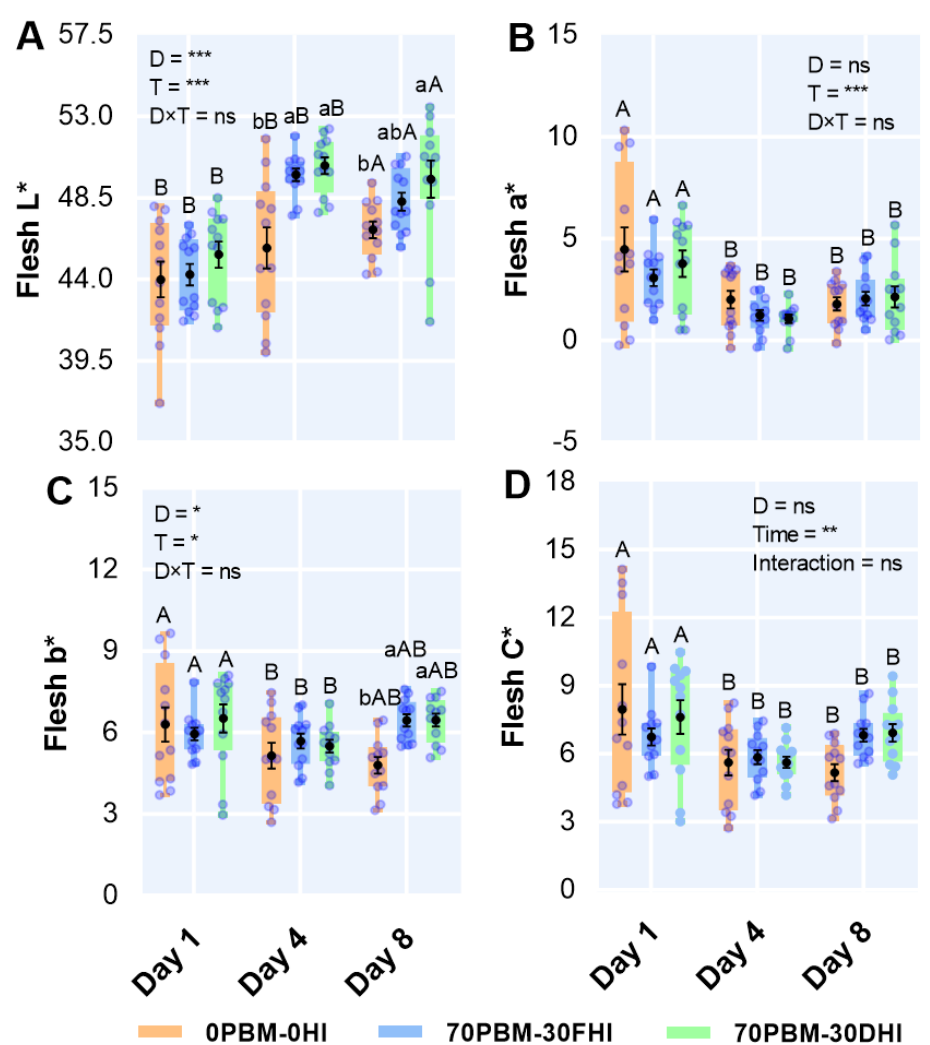
Figure 4. Changes in the fillet flesh color, including the lightness (L*) ( A ), redness (a*) ( B ), yellowness (b*) ( C ), and chroma (C*) ( D ) levels, after the 8-week feeding trial and at day 1, day 4 and day 8 when stored at 4 °C in barramundi fed complete replacement of fishmeal (FM) diets with mixtures of poultry by-product meal (PBM), full-fat Hermetia illucens (FHI), and partially defatted Hermetia illucens (DHI) larvae meal. Semi-transparent light blue round markers indicate individual datapoints ( n = 12), while the box–whisker plot of individual datapoints and black markers denote the mean and standard error values, respectively. Lower cases indicate significant differences between the treatments, while upper cases in the figure indicate significant differences between the storage days. Asterisks represent the significant differences at * p < 0.05, ** p < 0.01, and *** p < 0.001 and ns denotes non-significant.